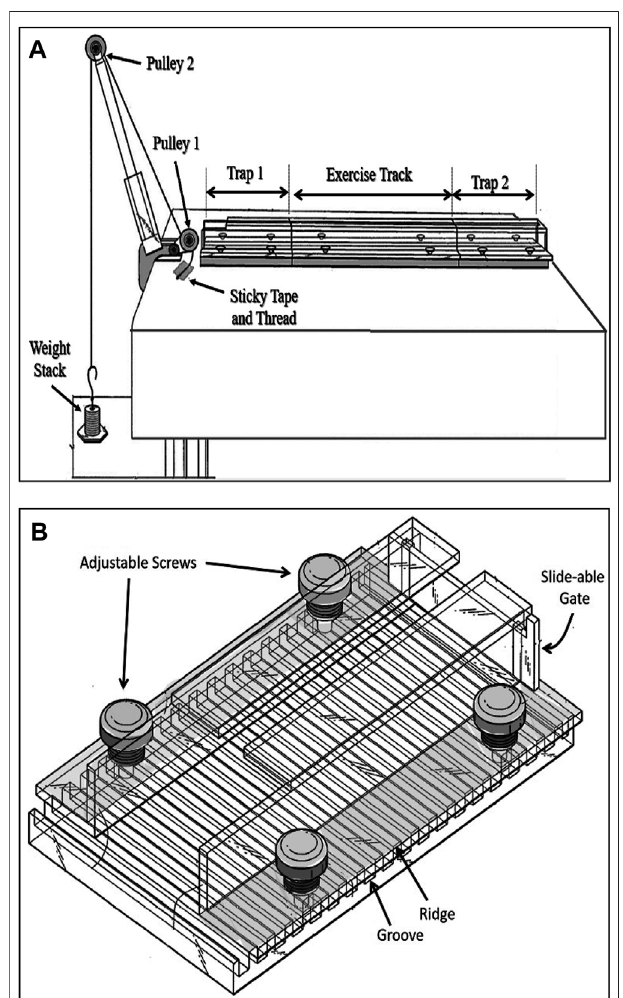
FIGURE 1 | The rat resistance exercise system. (A) The three sections-transparent tunnel positioned in front of a two pulley tower. Once the animal enters the trap 1 compartment (B) , a strong cotton rope that runs over twopulleysistiedtoaweightstackfromoneendandsecuredtothetailof a rat at the other end. The trap compartment is adjustable for width (4.5 – 8 cm) andheight(4 – 7 cm)throughmovablesidewallsandplacingofvariousthickness washers, respectively. It has a slide-able gate in